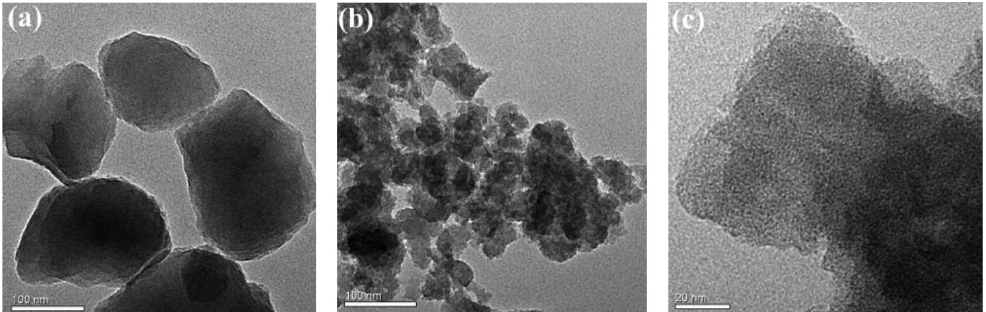
SiW (a), NiHSiW (b), UiO-66 (c) and NiHSiW/UiO-66 (d) catalysts. Figure 3: SEM images of H 4